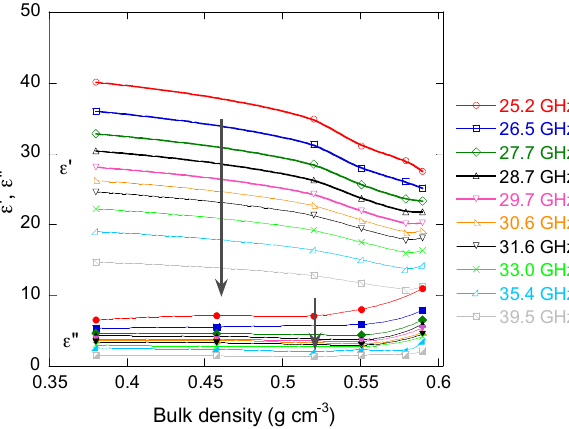
Figure 12. Frequency dependence of real ( ε ’ ) and imaginary ( ε ” ) parts of the effective permittivity as a function of bulk density. The arrows indicate the increase of frequency at which the measurements were carried out.